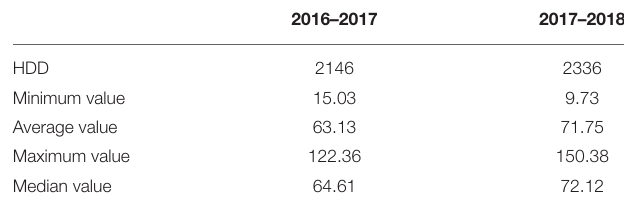
TABLE 4 | Synthesis of the measured data (thermal energy consumption for heating) in kWh/m 2 y for the total occupied